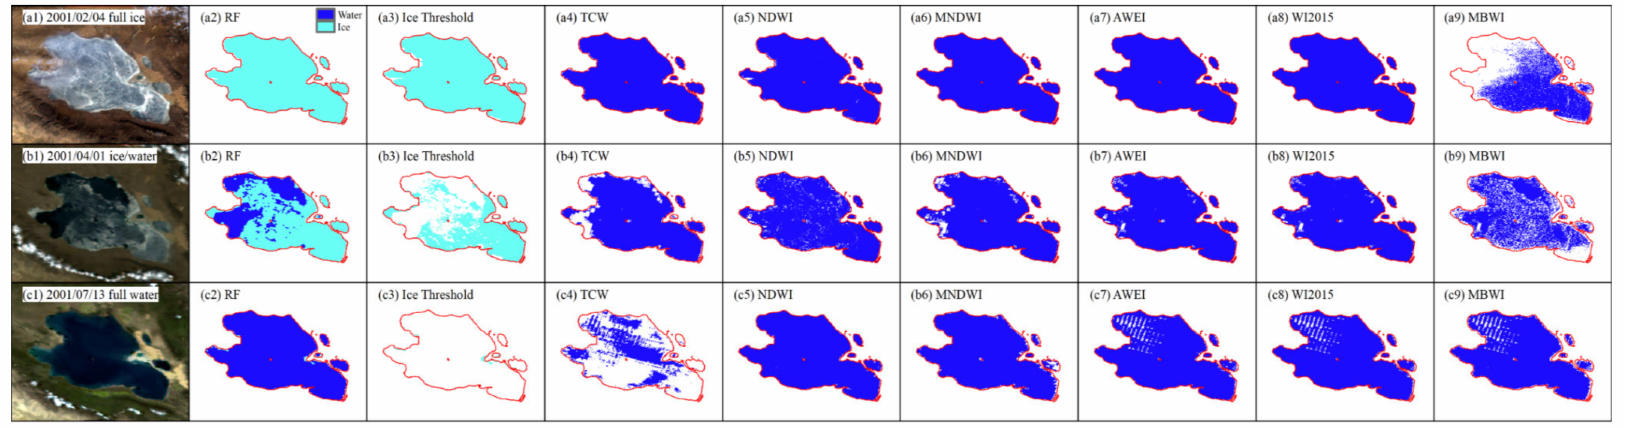
Figure 4. MODIS images with full ice cover, ice-water cover, and full water scenes and the corresponding ice / water extracted results based on several methods for 4 February 2001 ( a1 – a9 ), 1 April 2001 ( b2 – b9 ) and 13 July 2001 ( c2 – c9